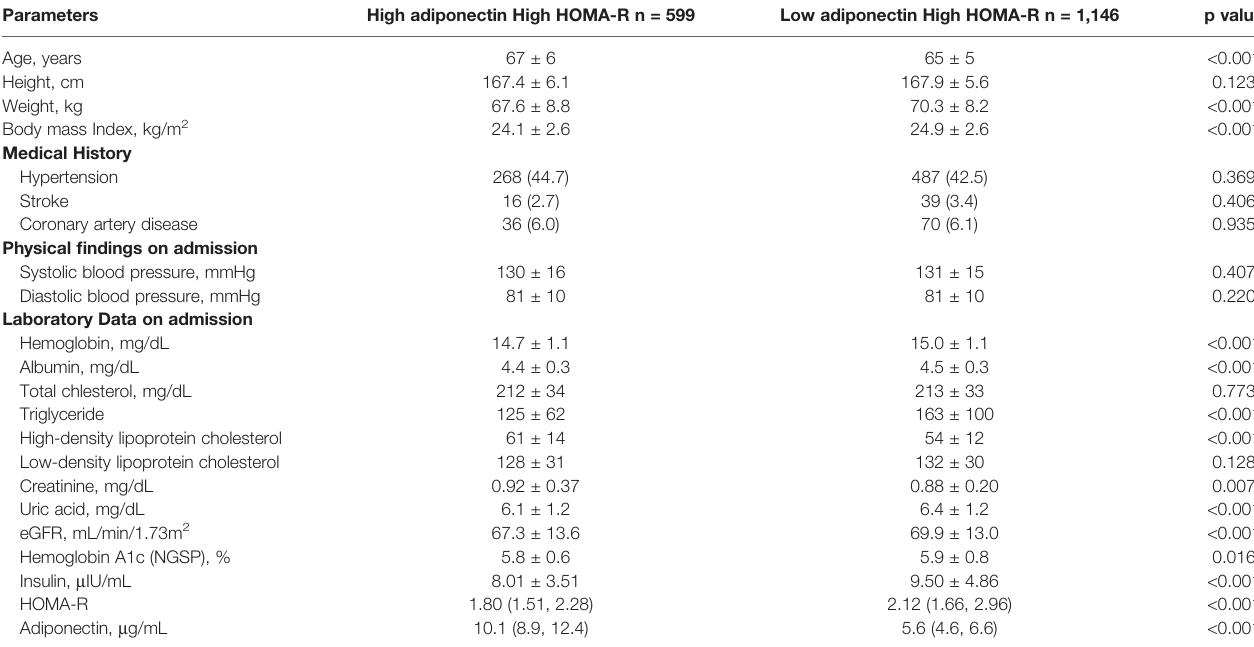
TABLE 2A | Clinical and biological characteristics of high HOMA-R 1,745 males strati fi ed by H-adiponectin/H-HOMA and H-adiponectin/L-HOMA. Parameters High adiponectin High HOMA-R n = 599 Low adiponectin High HOMA-R n = 1,146